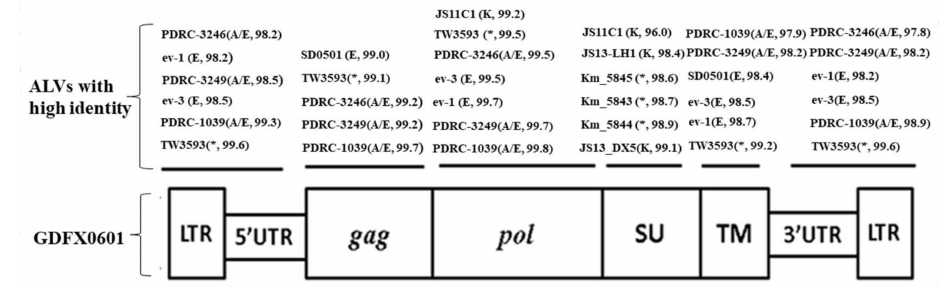
Figure 3. The genome structure of GDFX0601. The reference strains with high sequence similarity to this isolate are shown above the genome structure. *: The isolates whose subgroups are not